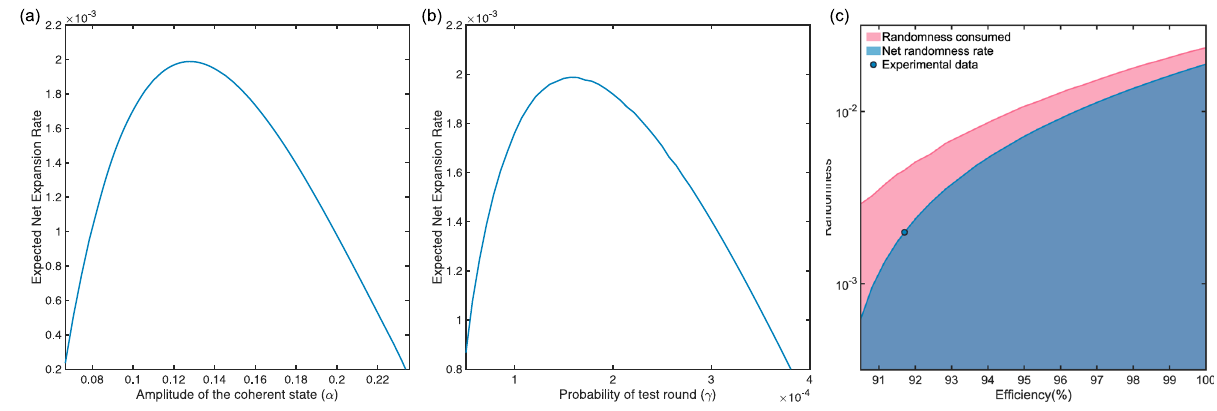
Fig. 4 | PerformanceAnalysis2.a , b Theexpected netrandomnessexpansionrate oftheQRNGversusthe( b )amplitudeofthequantumstate α and( c )theprobability oftestrounds γ ,with η eff =91.7%. c Theexpectednetrandomnessexpansionrateand